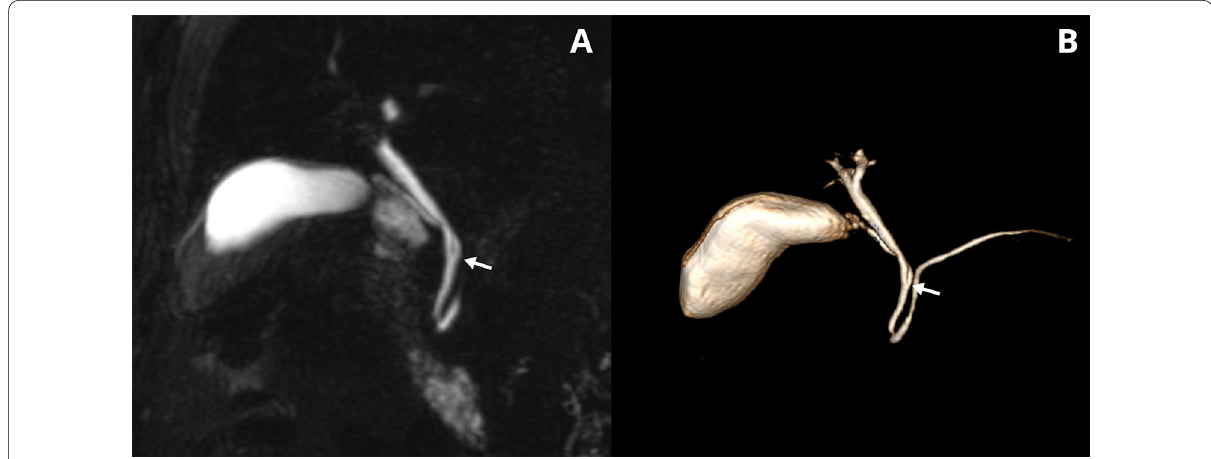
Fig. 4 A patient with low-medial insertion of cystic duct with no choledocholithiasis. The Coronal ( a ) and 3D volume rendering ( b ) MRCP images demonstrate the low medial insertion (white arrow) of cystic duct with no stone in the common bile